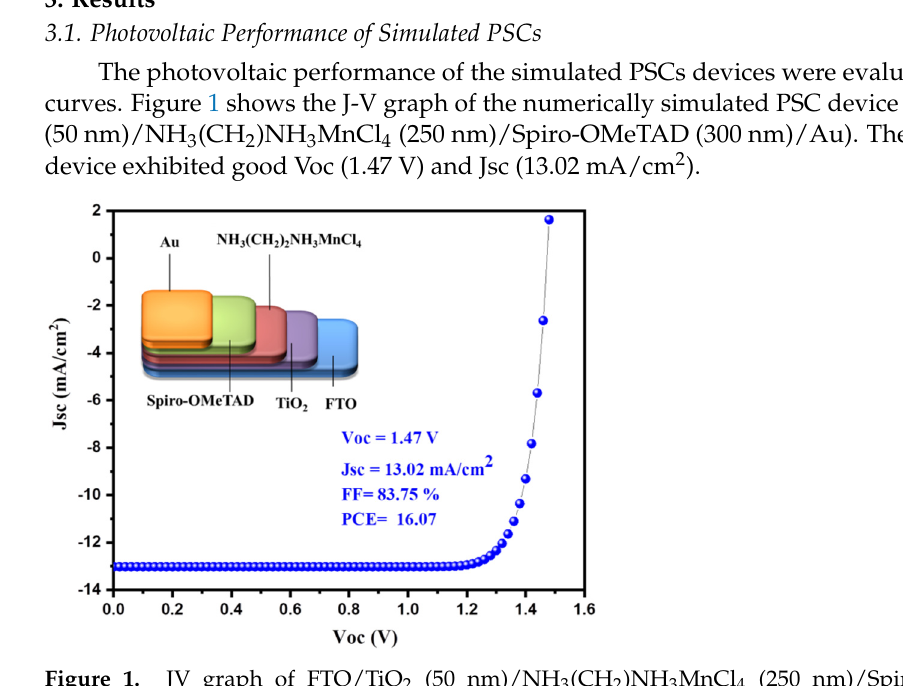
Figure 1. JV graph of FTO/TiO 2 (50 nm)/NH 3 (CH 2 )NH 3 MnCl 4 (250 nm)/Spiro ‐ OMeTAD (300 nm)/Au.